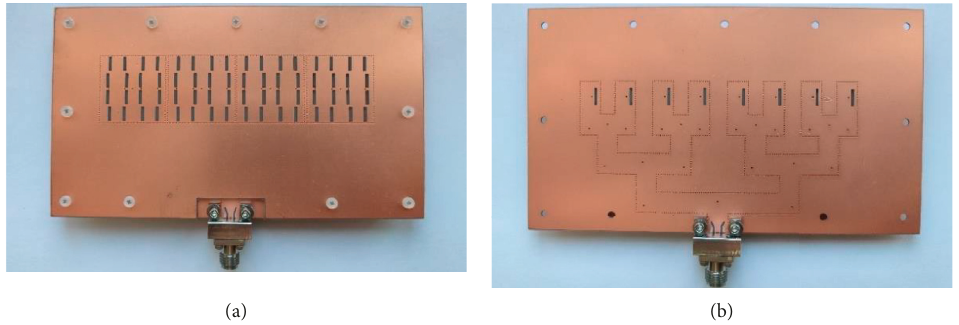
Figure 13: Photograph of the proposed 1 × 4 antenna array. (a) Top layer. (b) Bottom layer.